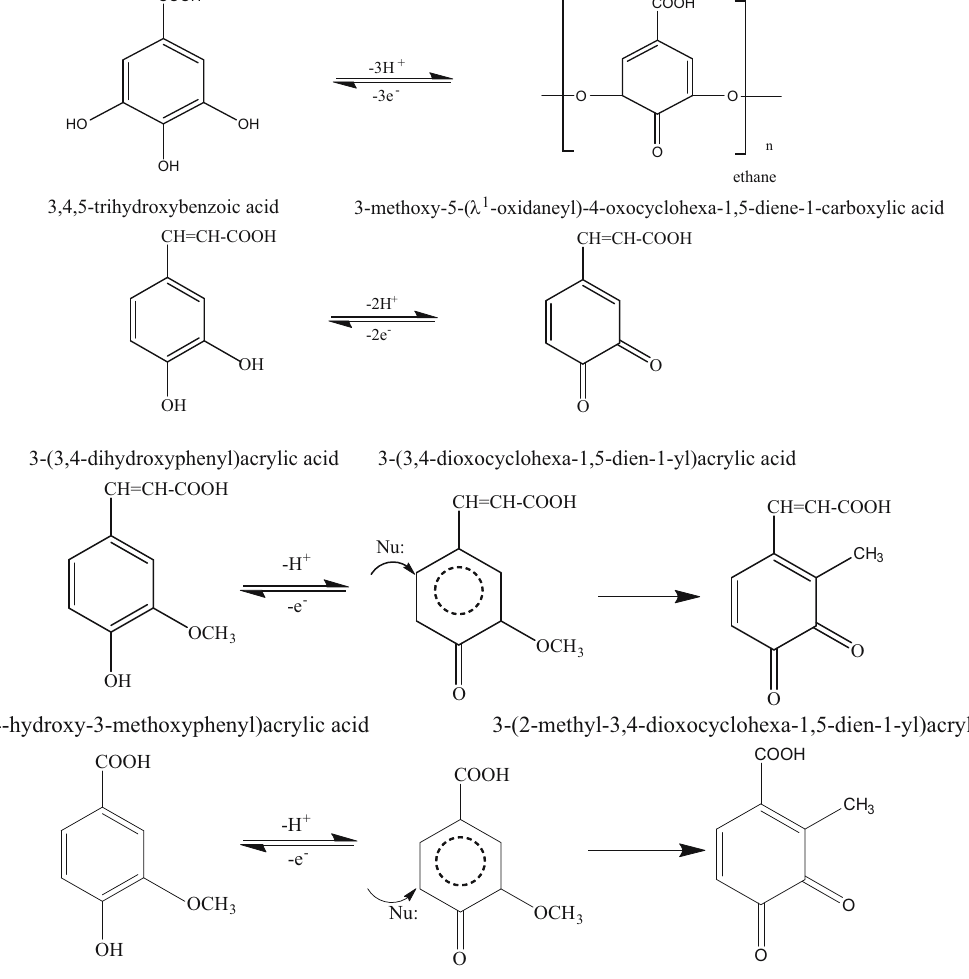
Figure 6: The electrochemical oxidation mechanism of four polyphenolic